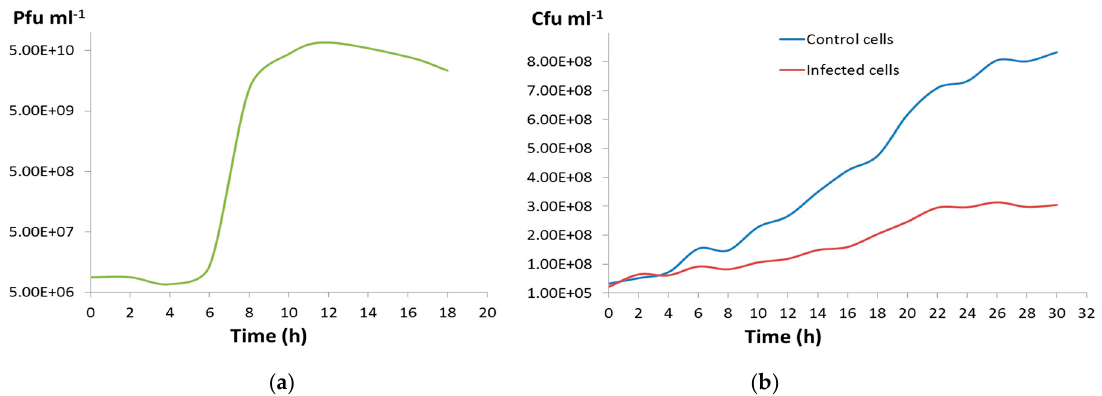
Figure 4. ( A ) One-step growth curve for CG φ 29. ( B ) Blue line shows cell numbers per ml of an uninfected CGM5-S host culture, and red line shows mean cell numbers per ml of triplicate infected CGM5-S host cultures.